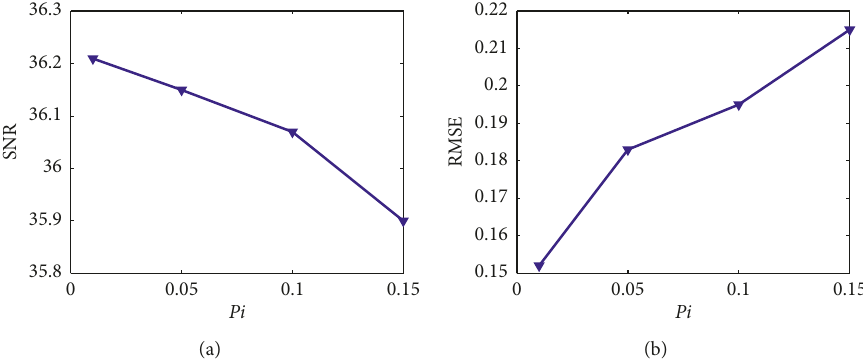
Figure 9: The effect of different parameter p